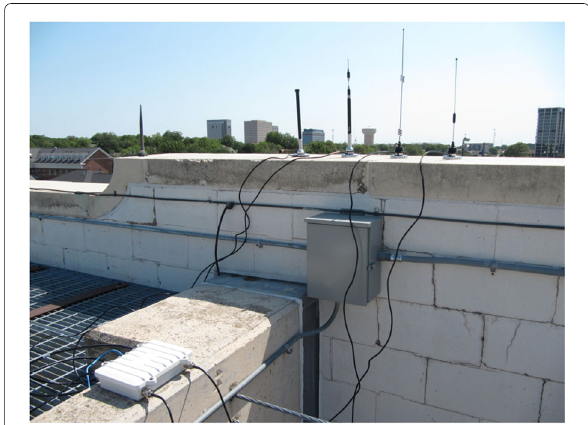
Fig. 9 Gateworks board with four Ubiquiti radios and antennas at 900 MHz, 2.4 GHz, and 5.8 GHz on top of a parking garage on campus.